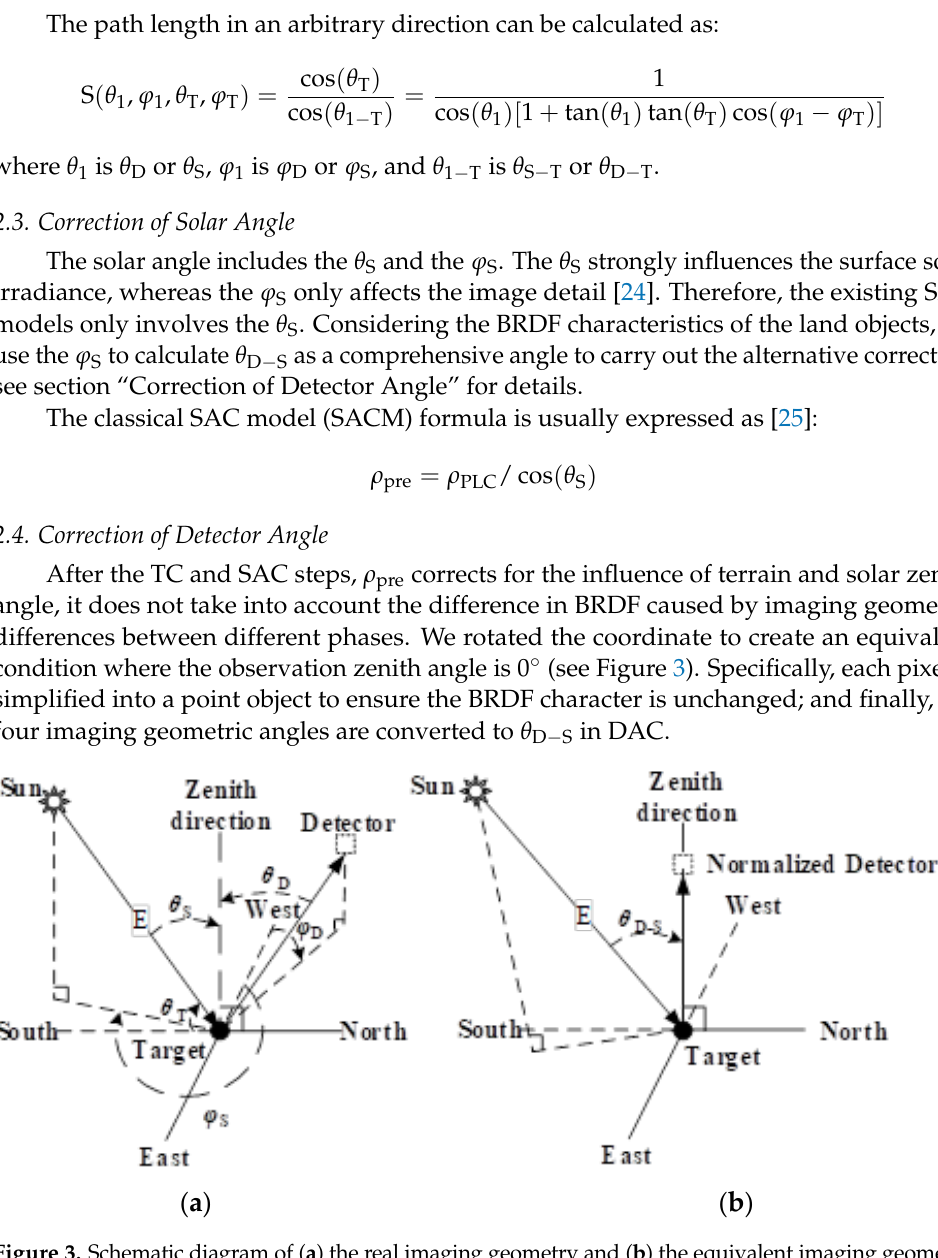
Figure 3. Schematic diagram of ( a ) the real imaging geometry and ( b ) the equivalent imaging geometry.